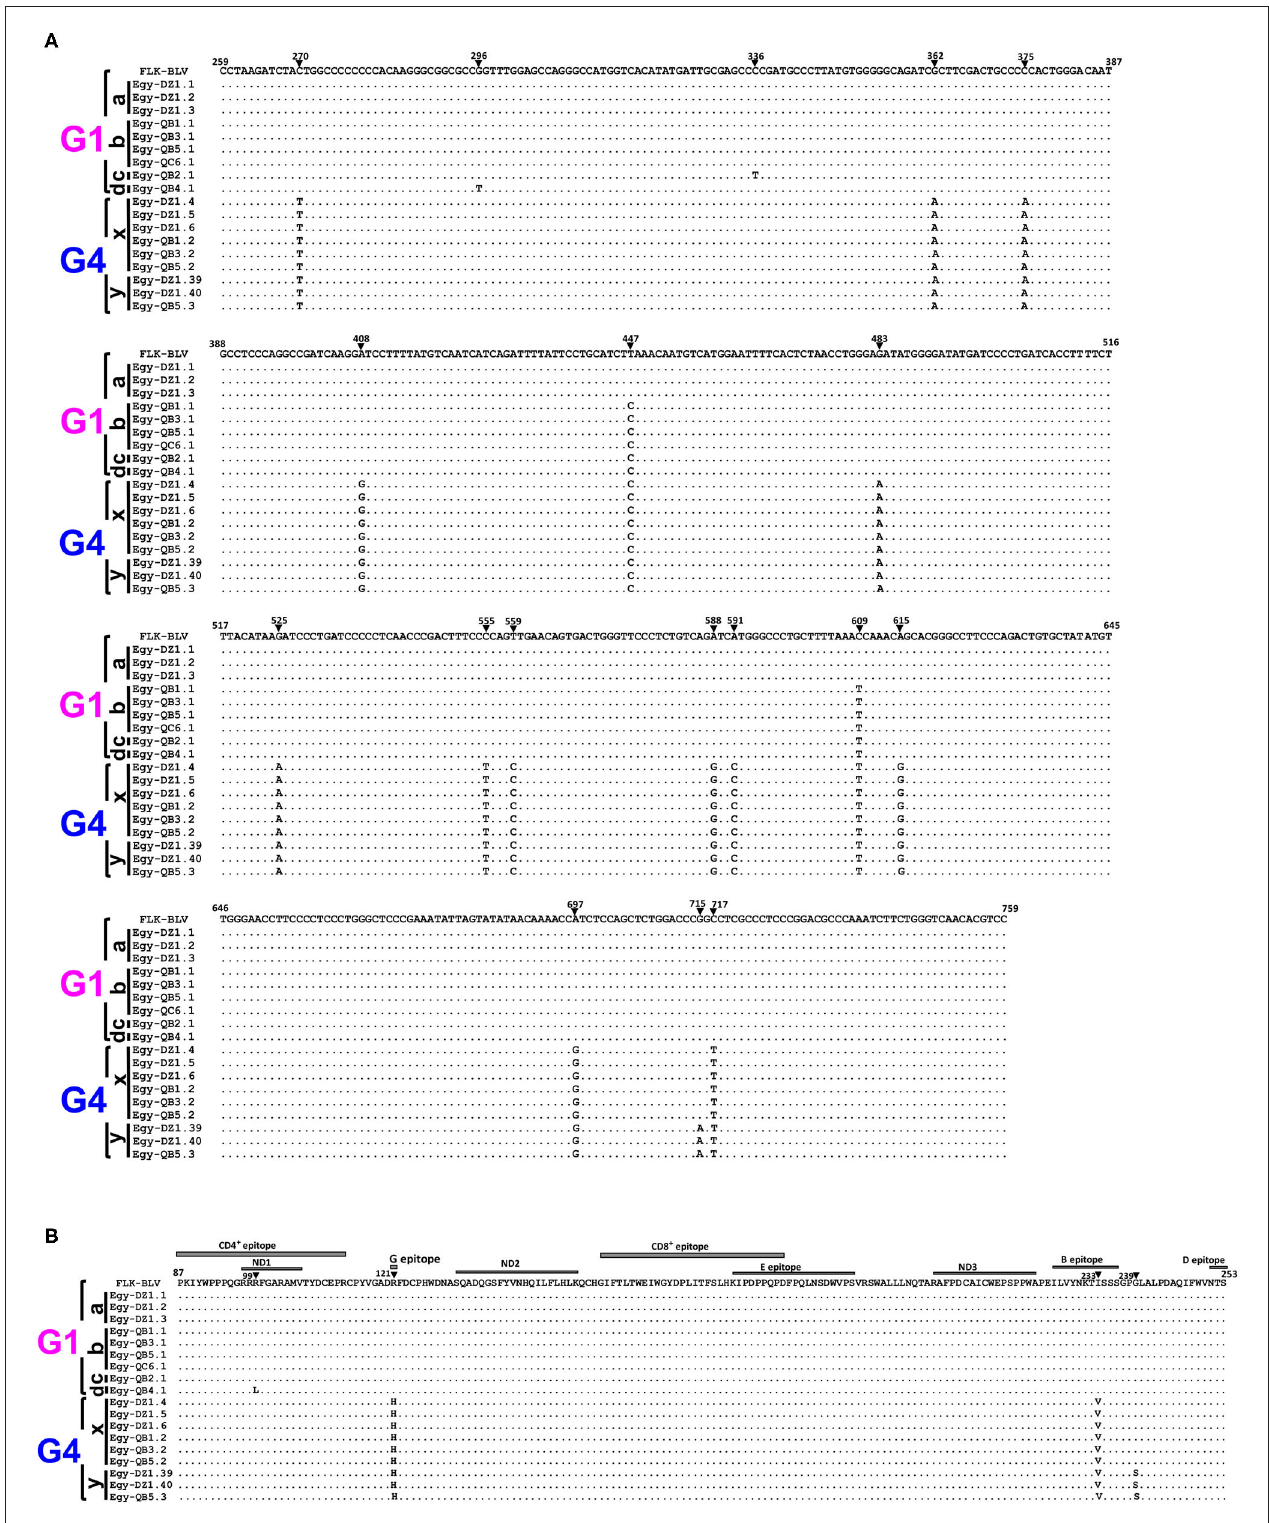
FIGURE 4 | Alignment of nucleotide sequences and deduced amino acid sequences of 501-bp nucleotide of BLV env -gp51 gene from the six genetically distinct strains identified in Egyptian cattle. Alignment was performed for the selected 18 typical Egyptian BLV isolates representative for the six genetically distinct strains